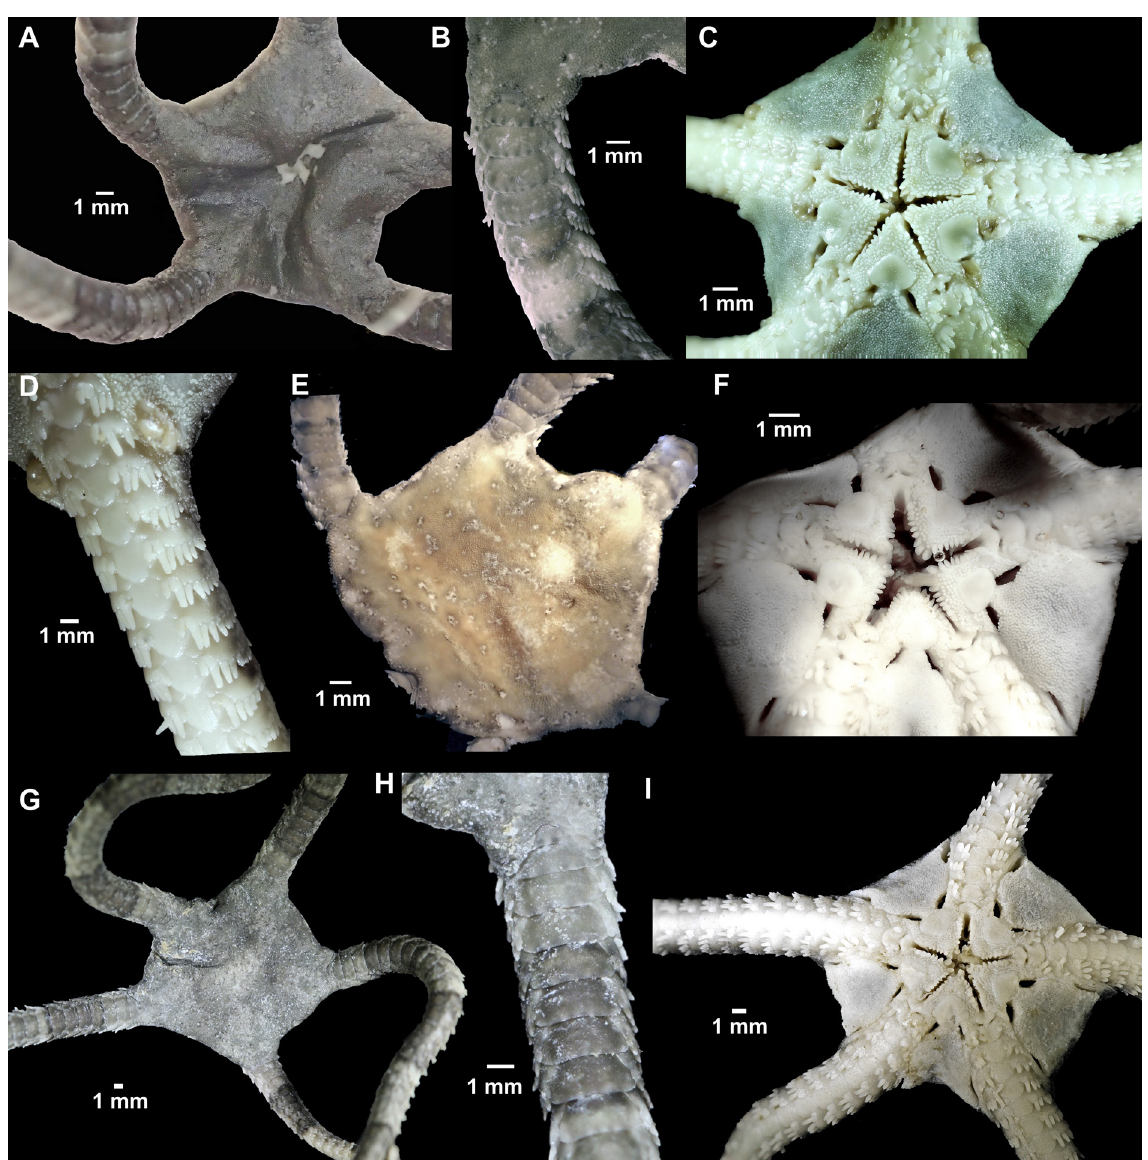
Fig. 5. Ophioderma guineense Greef, 1882, material from Thiouriba, Senegal, digital images. A – D . Dark brown specimen with light green ventral side (SMNH-95511#1). A . Dorsal aspect. B . Dorsal arm. C . Ventral aspect. D . Ventral arm. – E – F . Light brown specimen with spotted disc and white ventral side (SMNH-95511#2). E . Dorsal aspect. F . Ventral disc. – G – I . Grey-brown specimen with spotted disc and white ventral side (SMNH-95511#3). G . Dorsal aspect. H . Dorsal arm. I . Ventral